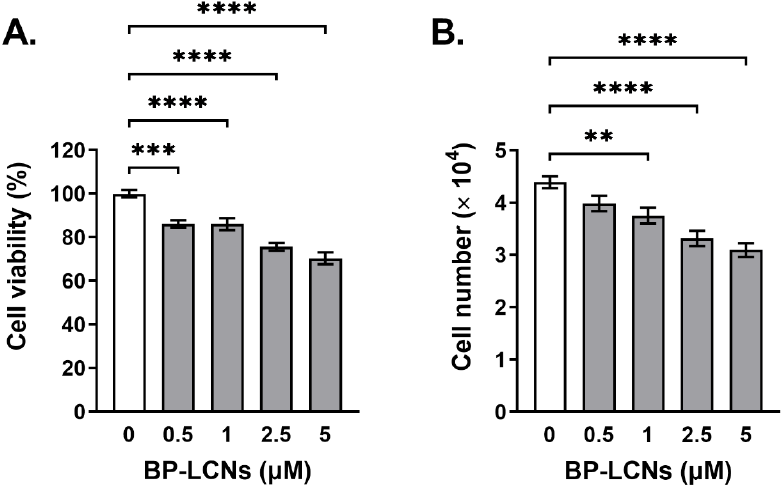
Figure 8. Effect of BP-LCNs on proliferation of A549 cells. A549 cells were incubated at 37 °C for 24 h in the absence or presence of BP-LCNs (final concentration of 0.5, 1, 2.5, or 5 µM). They were then incubated at 37 °C for 4 h with MTT solution (final concentration 250 µg/mL) or stained with trypan blue. Formazan crystals were dissolved with DMSO. and the absorbance was measured by microplate reader ( A ). Trypan blue stained cells were counted using a cell counter ( B ). The values represent Mean ± SEM of 3 independent experiments. Note: ** p < 0.01, *** p < 0.001, **** p < 0.0001. Abbreviation: BP-LCNs, berberine – phytantriol liquid crystalline nanoparticles.